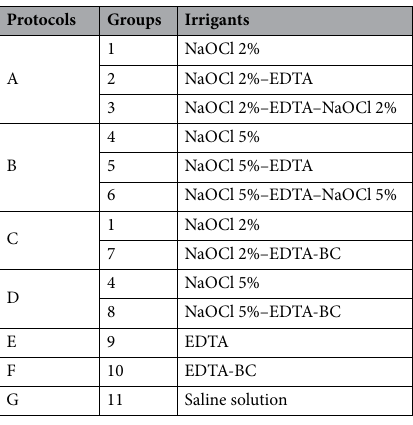
Table 1. Irrigants tested alone (NaOCl, EDTA, EDTA-BC and saline) or combined in different sequences. NaOCl sodium hypochlorite, EDTA 17% ethylene diamine tetracetic acid, BC benzalconium